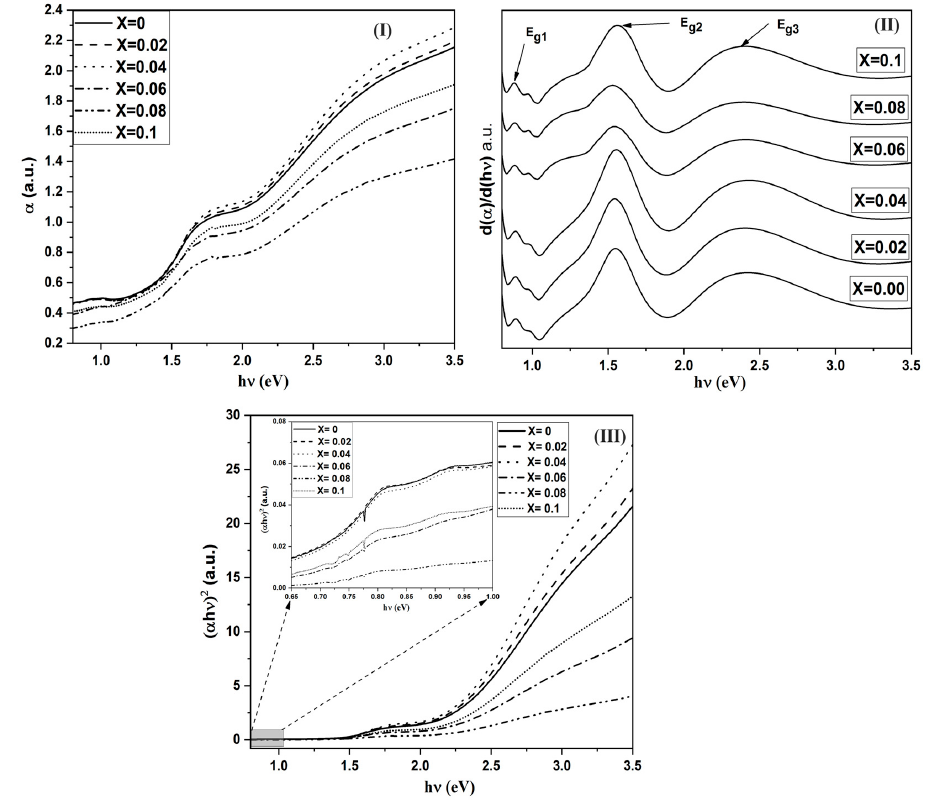
Figure 4. ( I ) the absorption coefficient against the photon energy for all films of Cr x Co 3 − x O, ( II ) the derivative of α against the photon energy for Cr x Co 3 − x O 4 samples and ( III ) the variation of ( α h ν ) 2 against the photon energy for all films of Cr x Co 3 − x O 4 .